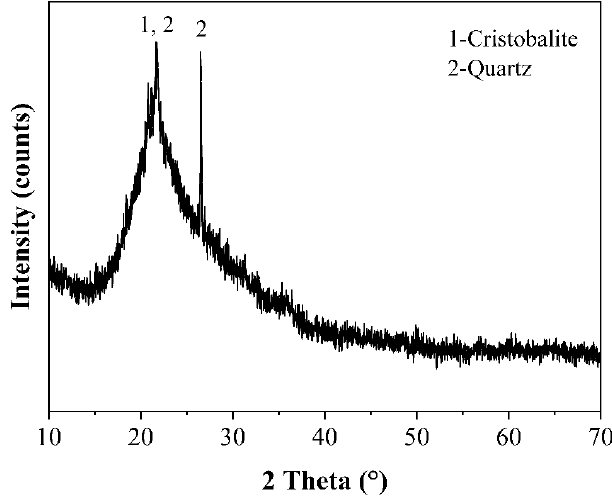
Figure 3. XRD pattern of RHA.